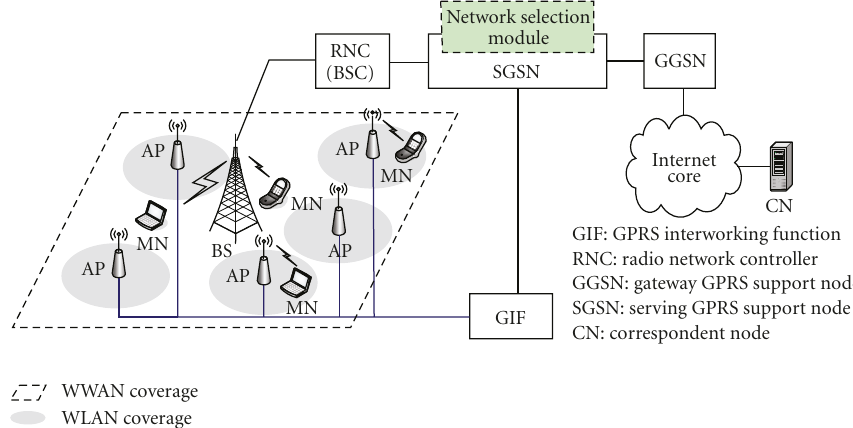
Figure 1: An overall heterogeneous networking system architecture for the proposed vertical handover decision